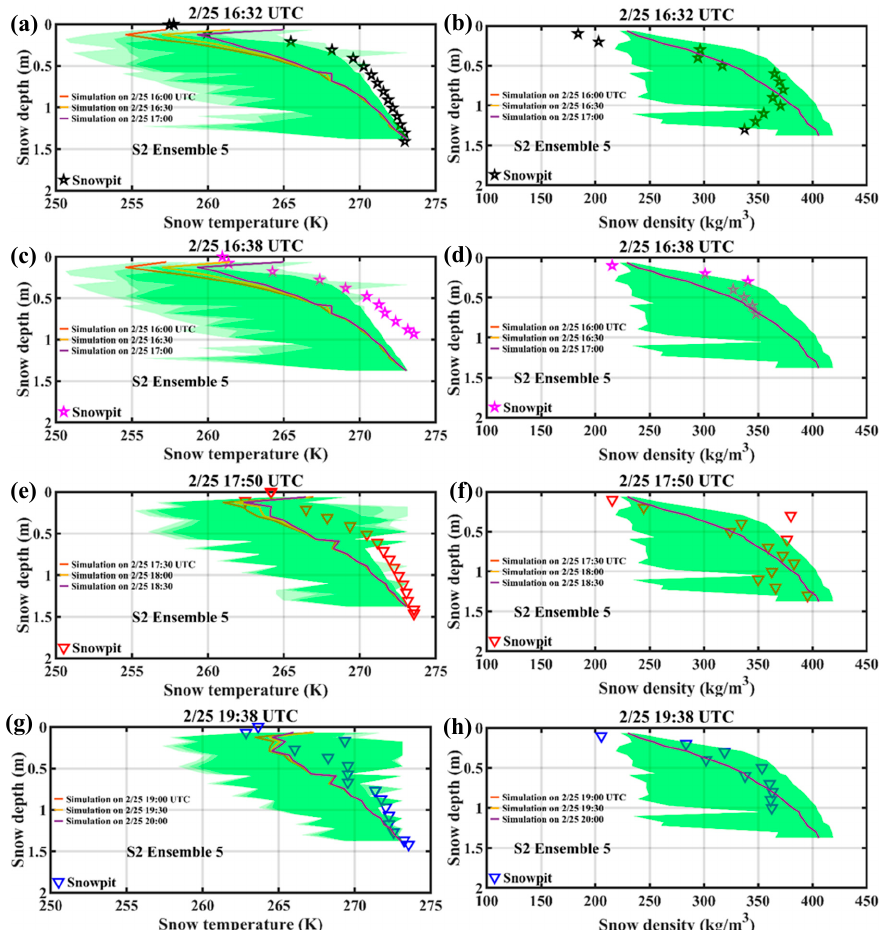
Figure 7. Evaluation of Ensemble 5 predictions of snow temperature ( a , c , e , and g ) and snow density ( b , d , f , and h ) against snowpit measurements within S2 on February 25. The continuous lines represent Ensemble 5 mean values at three distinct times close to the reported time of snowpit measurements. The green envelope represents the min–max range of ensemble predictions at each depth. Each row is associated with one of four distinct snowpits identified by different markers according to the convention in Table S2.